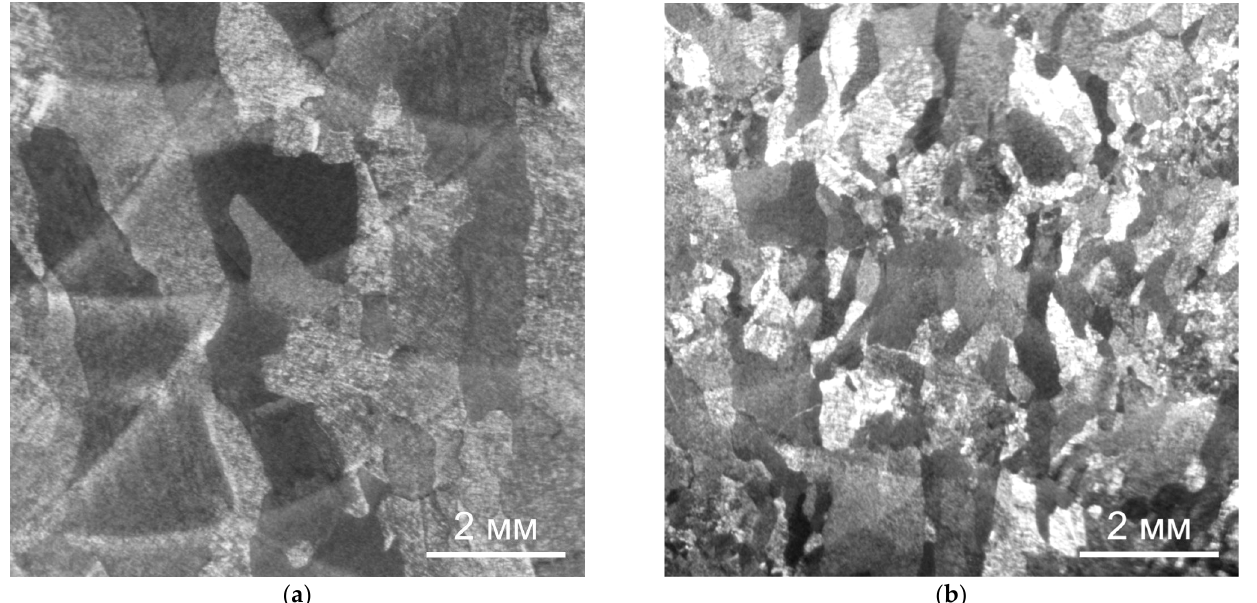
Figure 5. Macrostructure of the Ti-6Al-4V alloy during CMT deposition: ( a ) without forging, ( b ) with interpass forging.